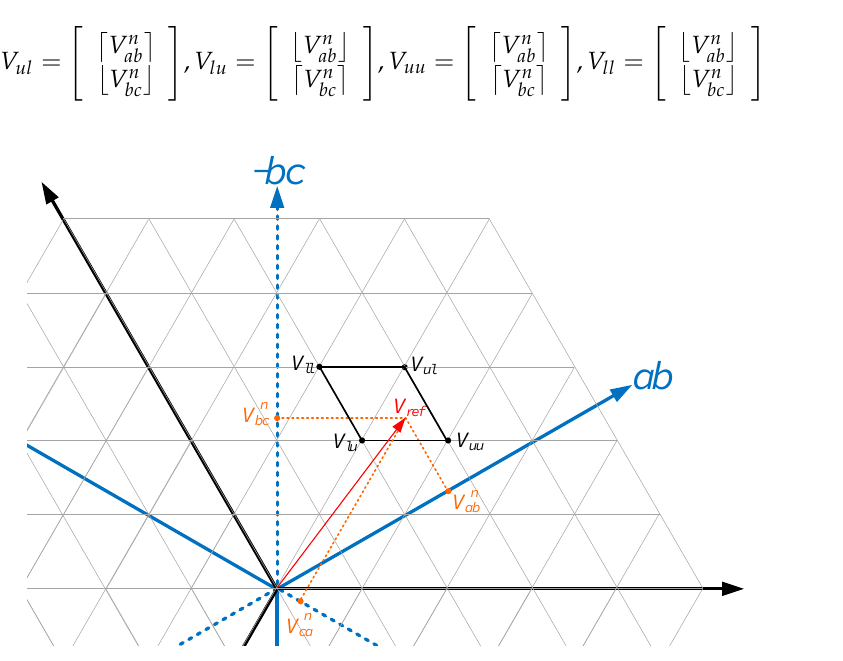
Figure 4. Graphic representation of fast SVM proposed in [14].